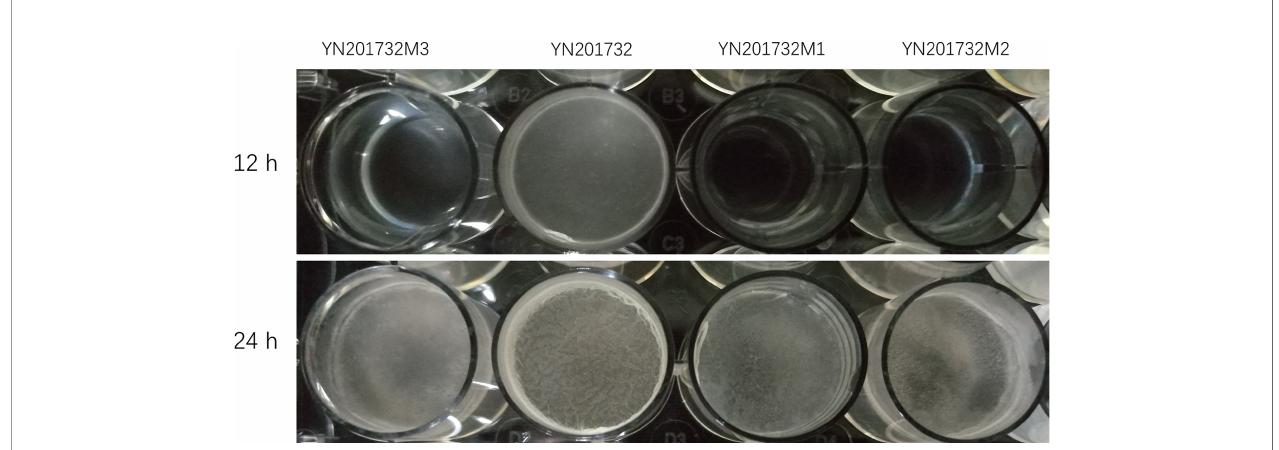
FIGURE 4 | Microtiter plate assay of bio fi lm formation by wild type and the mutant strains. Wild-type YN201732, YN201732M1, YN201732M2, and YN201732M3 cells were grown in MSgg medium at 37°C for the indicated times.